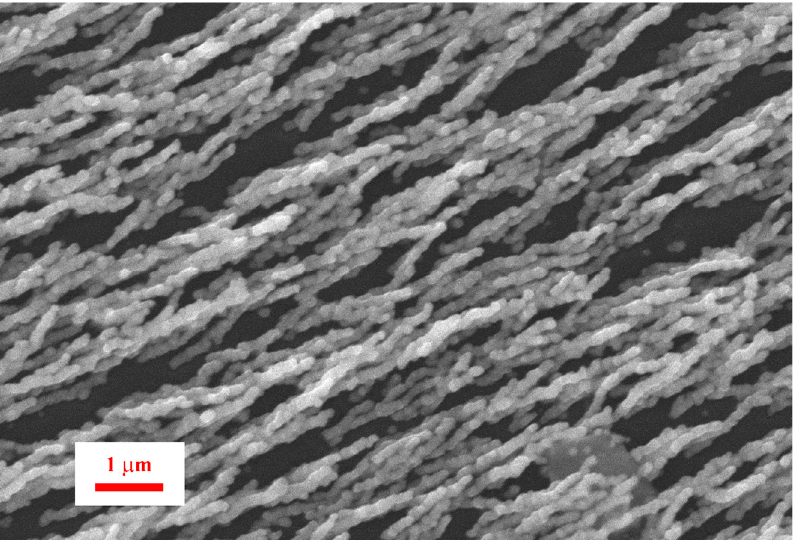
Figure 5. SEM image of aligned Ni nanowires (50% dilution).